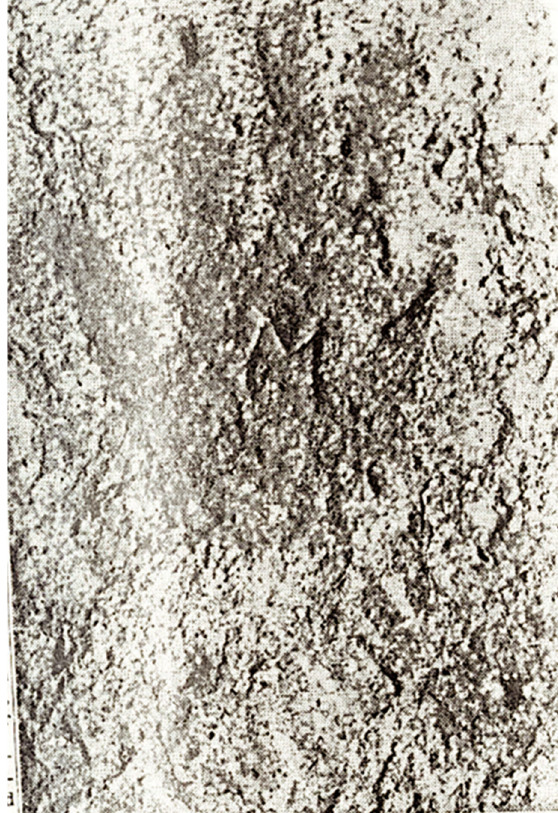
Figure 36. Tilden 2, locus 2. Berkeley Daily Gazette (Hansen